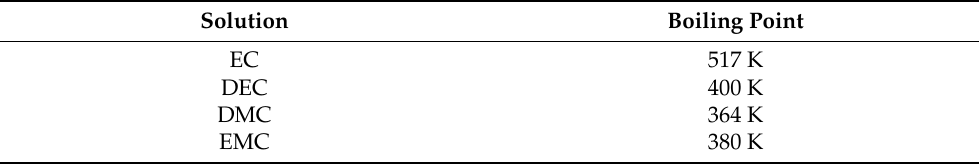
Table 2. Boiling point of electrolyte.